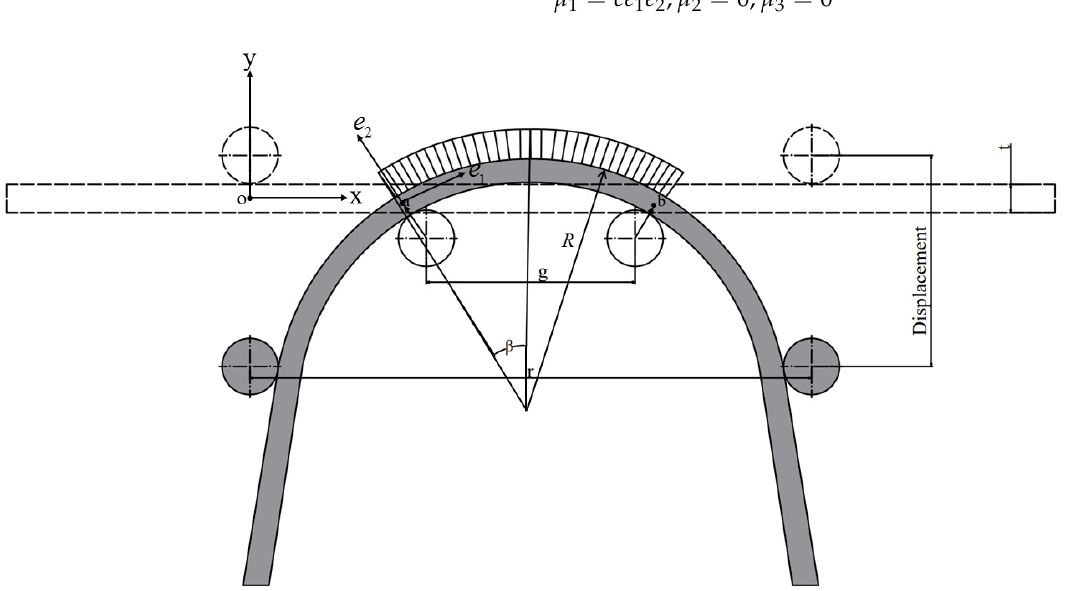
Figure 8. Geometrical schematic diagram of micro-bending deformation.